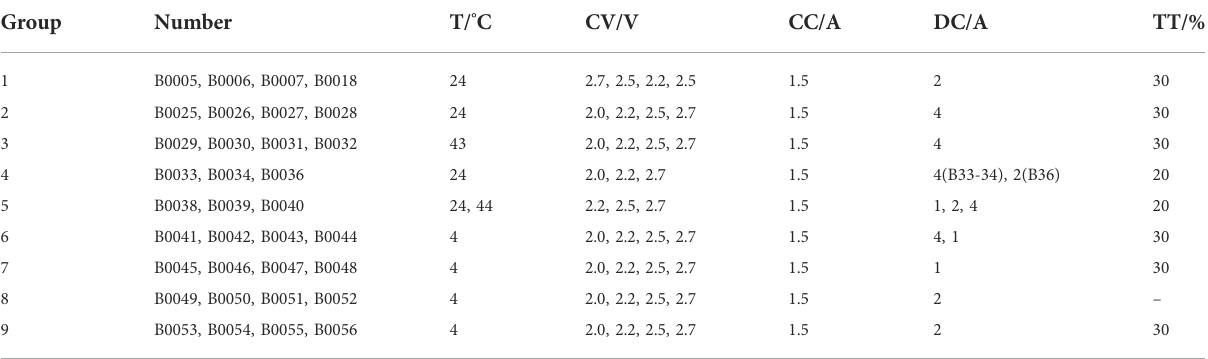
TABLE 1 NASA battery experimental dataset